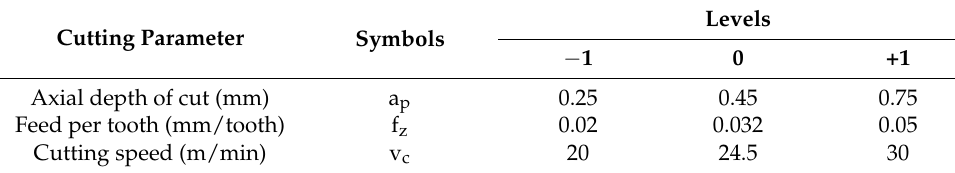
Table 4. Experimental plan.